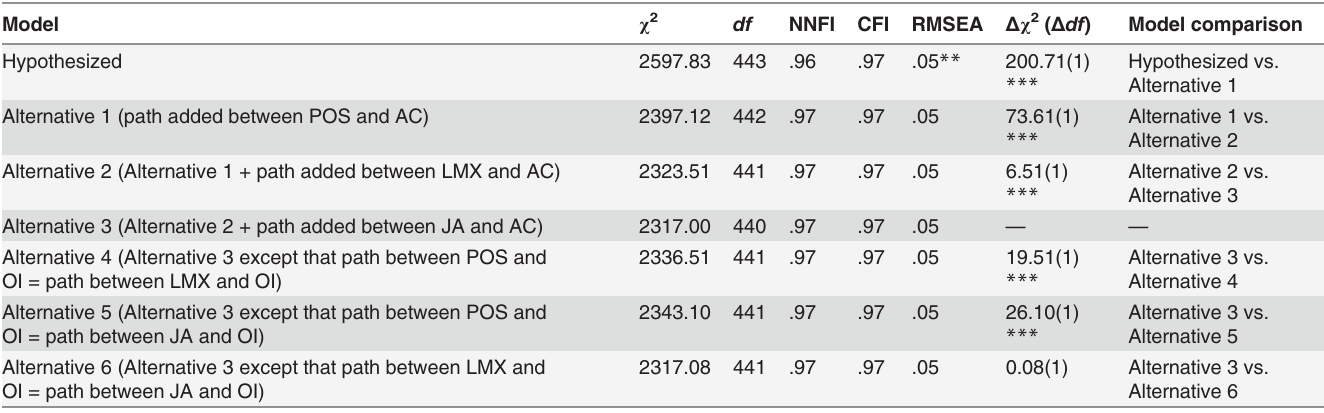
Table 3. Study 2: Fit Indices for Structural